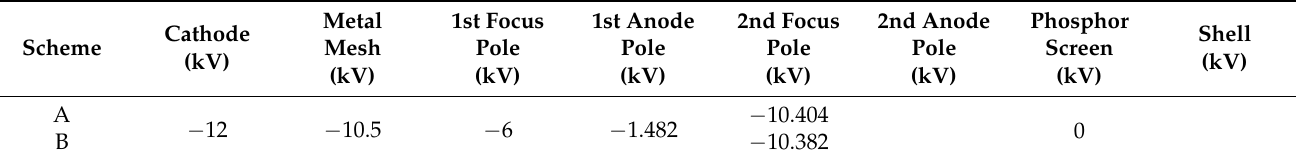
Table 2. Pole parameters of each scheme.